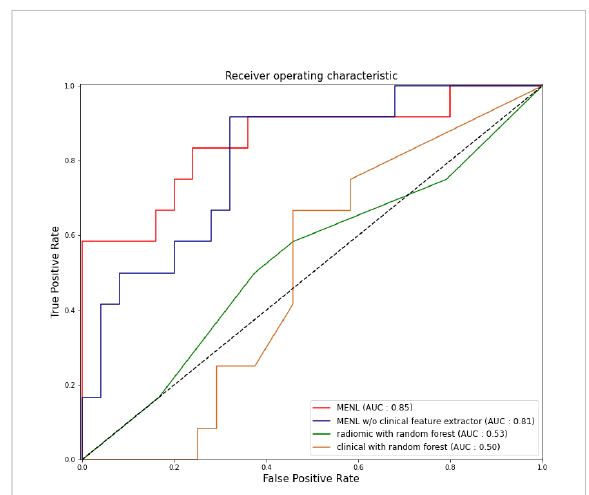
FIGURE 3 Receiver operating characteristic curves of the Multimodal Ef fi cientNet-b1 for Lung (MENL), MENL without clinical feature extractor, radiomics-based model, and clinical feature-based model in the test set (n = 37) of the primary cohort.